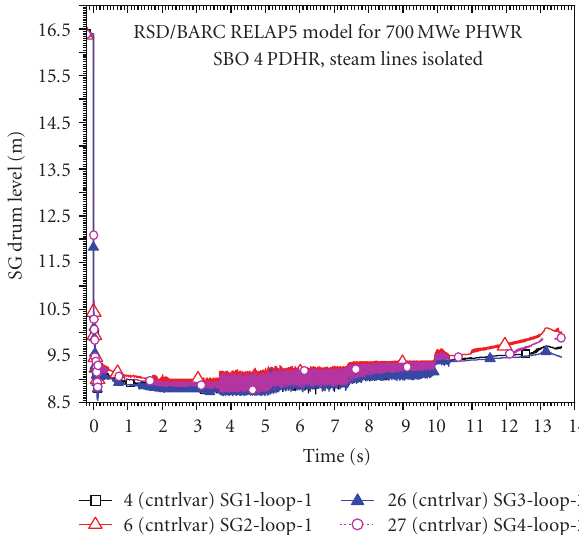
Figure 15: Clad temperature variation case-no delay in valving in PDHRS.